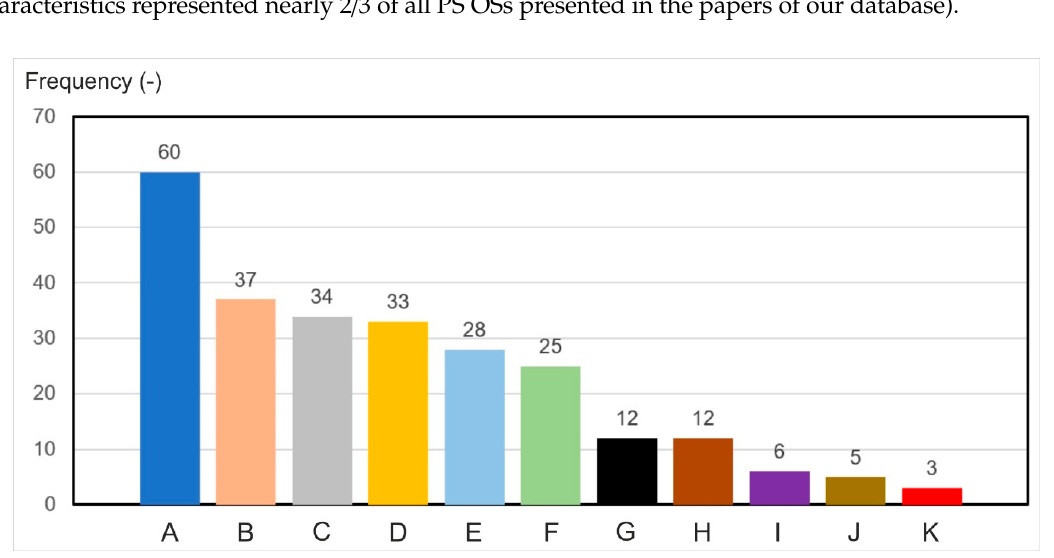
Figure 1. Frequency of individual PS ‐ OSs characteristics described in papers of our paper database— results of the first assignment process (paper groups are marked with the same letters as the paper groups listed above, see Table 1.).